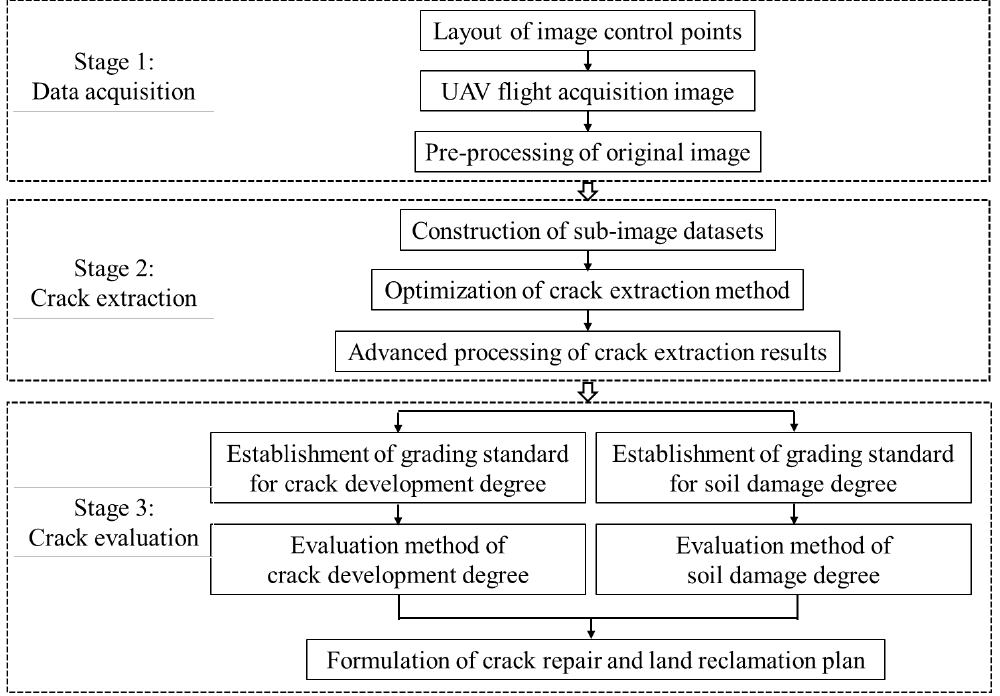
Figure 2. Technology roadmap for the research methodology.